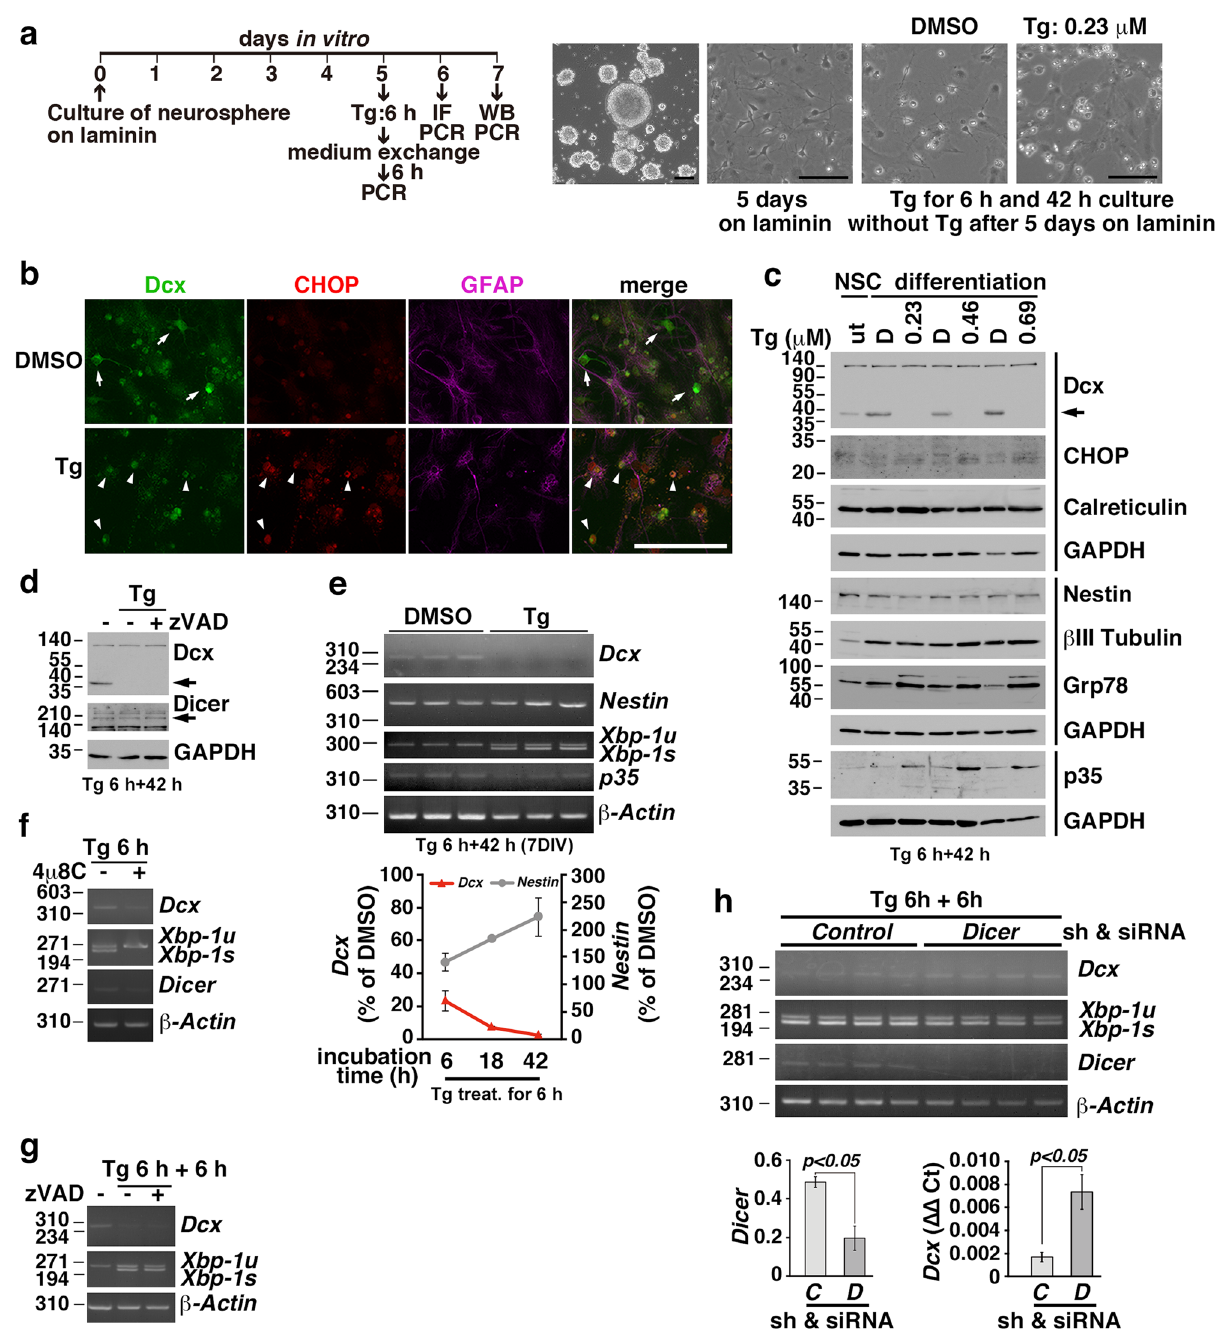
Figure 4. Thapsigargin reduced Dcx expression in immature neurons by decreasing the Dcx mRNA levels. (a) Experimental schedule and representative images. Hippocampal neurospheres from mice were differentiated on laminin for 5 days. The cells were treated with thapsigargin (Tg) for 6 h, washed once with medium, and then cultured in medium without Tg for the indicated amounts of times. ( b ) Immunostaining for Dcx, CHOP, and GFAP in differentiating cells cultured on laminin after Tg treatment for 6 h and in the absence of Tg for 18 h. Arrows: Dcx-expressing cells; arrowheads: Dcx- and CHOP-expressing cells. Scale bars: 100 µm ( a , b ). ( c ) Several neuronal lineage marker proteins, i.e., Dcx, calreticulin, nestin, βIII tubulin, were expressed in differentiating NSCs cultured on laminin, and the expression of the ER stress markers Grp78 and CHOP was induced by Tg. The arrow indicates Dcx. Cells were lysed at 42 h after Tg treatment for 6 h (Tg 6 h + 42 h). D: DMSO. ( d ) The cells were pretreated with 40 μM zVAD for 30 min, after which Tg (0.23 μM) was added and the cells were incubated for 6 h. After the medium was changed, the cells were incubated with 40 μM zVAD without Tg for 42 h. ( e ) Semiquantitative RT–PCR at 42 h after treatment with Tg (0.23 μM) for 6 h (upper panels). The mRNA levels of Dcx in cells cultured in medium without Tg were decreased at the indicated times after treatment with 0.23 μM Tg for 6 h (lower panel). The error bars represent the SEMs of 3 independent experiments. ( f, g ) The mRNA levels of Dcx were not changed after treatment with Tg (0.23 μM) for 6 h in the presence of the IRE1 inhibitor 4µ8C ( f ) or at 6 h after 0.23 μM of Tg treatment for 6 h in the presence of 40 μM zVAD ( g ). ( h ) Semiquantitative RT–PCR analysis of differentiating cells at 6 h after 0.23 μM Tg treatment for 6 h after the knockdown of Dicer using an shRNA and an siRNA (upper panels). Semiquantitative RT–PCR analysis of Dicer (lower left panel, p < 0.05, Student’s t test). shRNA and siRNA for the Control ( C ) and for Dicer ( D ). Real-time RT–PCR analysis of Dcx (lower right panel, p < 0.05, Student’s t test). The error bars represent the